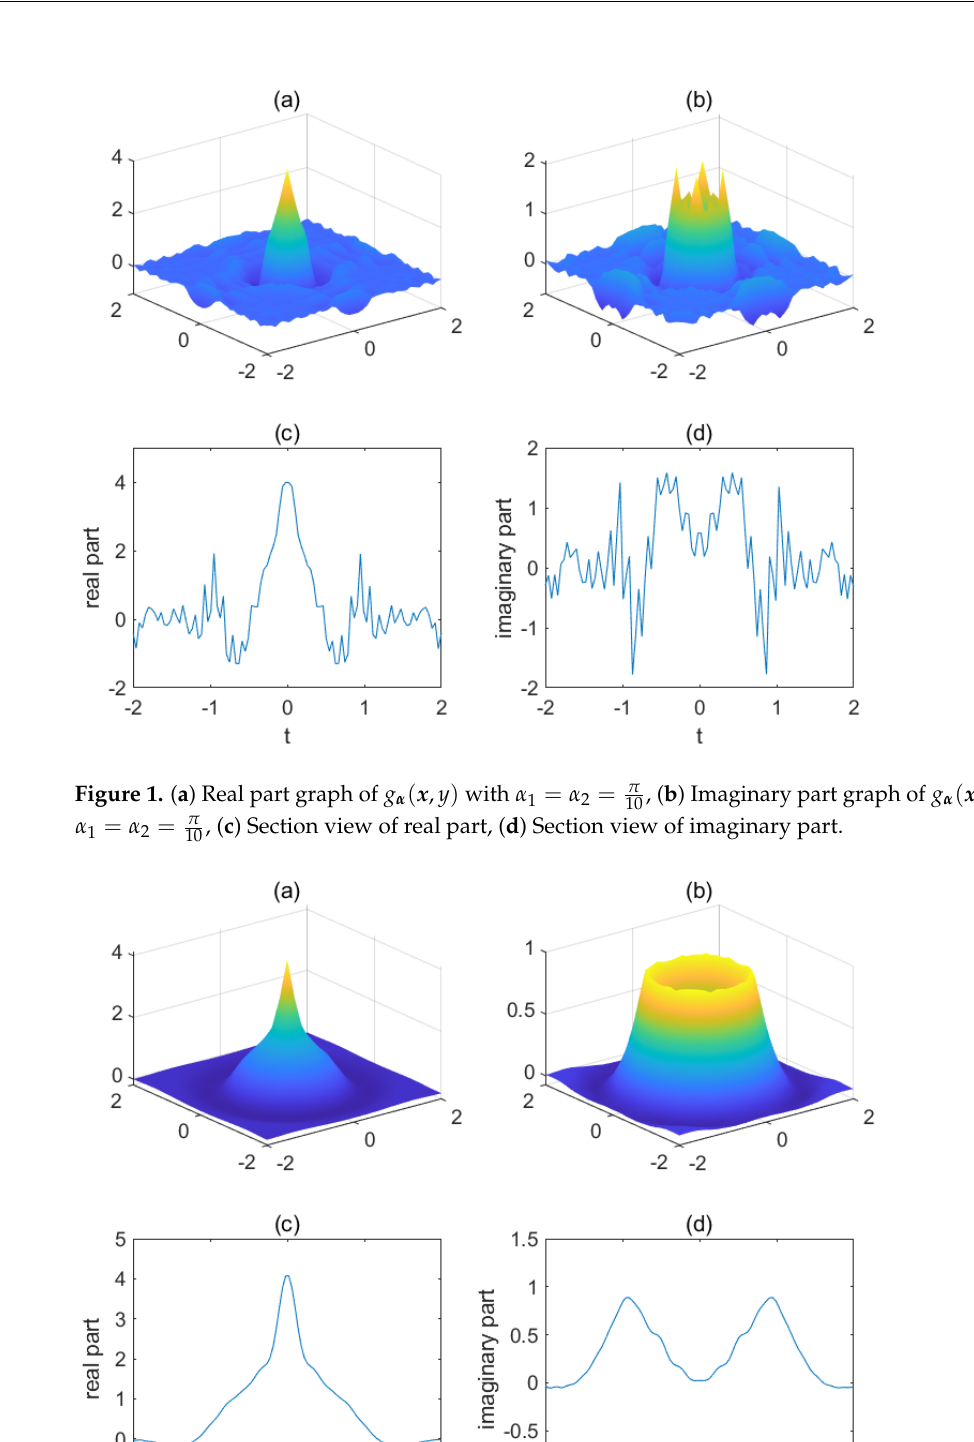
, ( b ) Imaginary part graph of g α ( x , y ) with 5